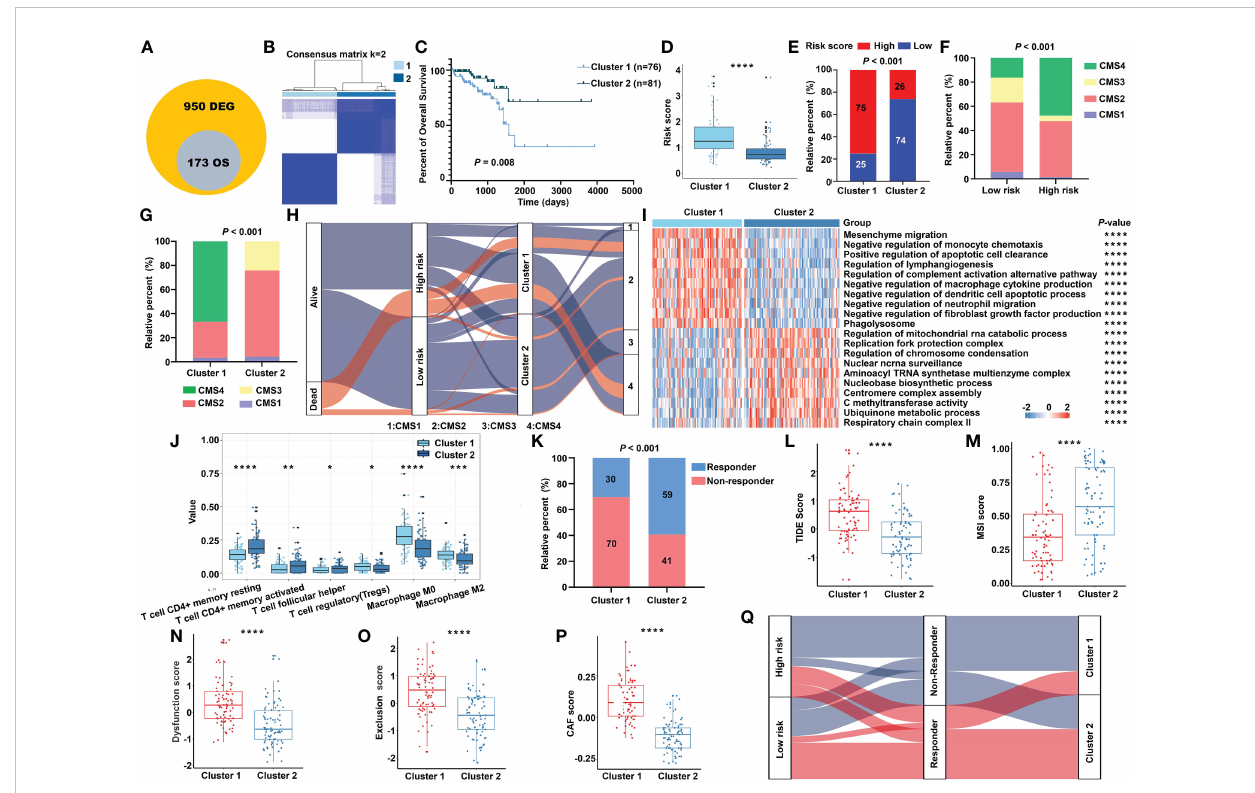
FIGURE 9 The transcriptomic characteristics of the m 5 C methylation – based gene clusters. (A) The intersection of DEGs and prognostic genes. (B) The unsupervised consensus cluster of the identi fi ed 173 genes. (C) The Kaplan – Meier survival curve for two clusters in the TCGA cohort. (D) The m 5 C signature – based risk score distribution between two clusters. (E) The proportion of READ patients with different risk status in cluster 1 and cluster 2 from the TCGA cohort. The CMS distribution among the risk groups (F) and clusters (G) separately. (H) Sankey diagram depicting the relationship of survival status, risk groups, clusters, and CMS classi fi cation. (I) The functional enrichment analysis on GO terms of the two clusters. (J) The immune cells in fi ltration between different clusters. (K) The proportion of responsive patients in the two clusters based on TIDE prediction. The distribution of TIDE score (L) , MSI score (M) , T-cell dysfunction score (N) , T-cell exclusion score (O) , and abundance of CAF (P) in cluster 1 and cluster 2. (Q) Sankey diagram connecting the two classi fi cation systems with the immune response. **** P < 0.0001; *** P < 0.001; ** P < 0.01; * P <